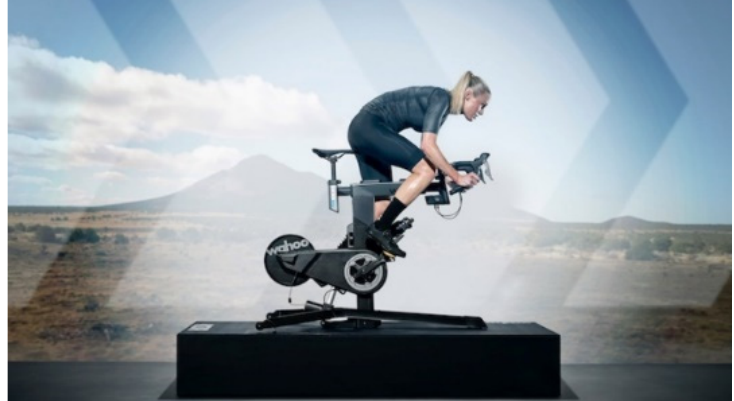
Figure 1. Photograph of an indoor exercise bicycle with screen.